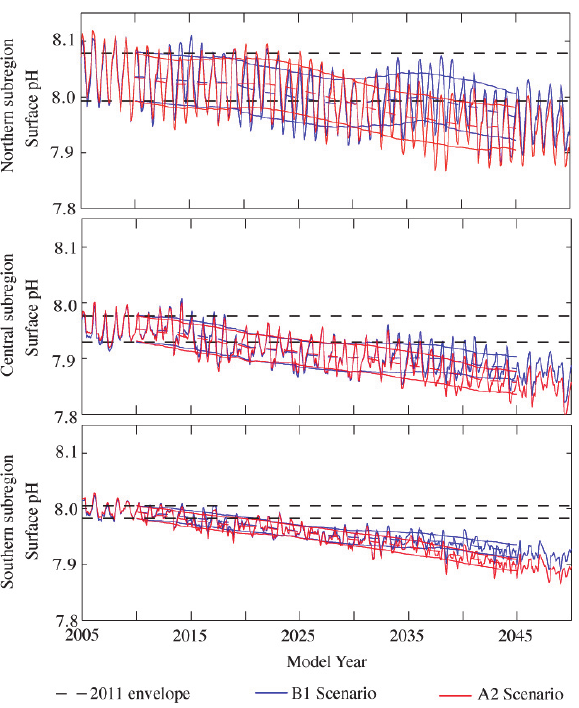
Fig. A3. Simulated time series of monthly mean surface (cid:127) arag for Fig. A3. Simulated timeseries of monthly mean surface (cid:127) for the two employed IPCC-SRES scenarios A2 Fig. A2. Simulated time series of monthly mean surface pH for the arag the two employed IPCC-SRES scenarios A2 (red) and B1 (blue), for Fig. A2. Simulated timeseries of monthly mean surface pH for the two employed IPCC-SRES scenarios A2 two employed IPCC-SRES scenarios A2 (red) and B1 (blue), for (red) and B1 (blue), for the northern (top panel), central (center panel) and southern (bottom panel) the northern (top panel), central (center panel) and southern (bottom (red) and B1 (blue), for the northern (top panel), central (center panel) and southern (bottom panel) the northern (top panel), central (center panel) and southern (bot- panel) subregions, with the 10-yr running average (dashed red and subregions, with the 10-yr running average (dashed red and blue lines) of the mean for all grid cells of each tom panel) subregions, with the 10-yr running average (dashed red subregions, with the 10-yr running average (dashed red and blue lines) of the mean for all grid cells of each blue lines) of the mean for all grid cells of each subregion. The subregion. The area between the solid lines defines the range of annual variability or envelope (mean ± 1 STD) and blue lines) of the mean for all grid cells of each subregion. The area between the solid lines defines the range of annual variability subregion. The area between the solid lines defines the range of annual variability or envelope (mean ± 1 STD) area between the solid lines defines the range of annual variability of (cid:127) for 2011 (black, ∼ 395 ppm atmospheric p CO 2 ) and the transient simulations following the A2 (red) or envelope (mean ± 1STD) of (cid:127) arag for 2011 (black, ∼ 395ppm arag or envelope (mean ± 1STD) of pH for 2011 (black, ∼ 395ppm at- of pH for 2011 (black, ∼ 395 ppm atmospheric p CO 2 ) and the transient simulations following the A2 (red) atmospheric p CO 2 ) and the transient simulations following the A2 and B2 (blue) emissions scenarios. The results are based on simulations with the 15 km resolution set up. mospheric p CO 2 ) and the transient simulations following the A2 (red) and B2 (blue) emissions scenarios. The results are based on and B2 (blue) emissions scenarios. The results are based on simulations with the 15 km resolution set up. (red) and B2 (blue) emissions scenarios. The results are based on simulations with the 15-km resolution simulations with the 15-km resolution set-up.